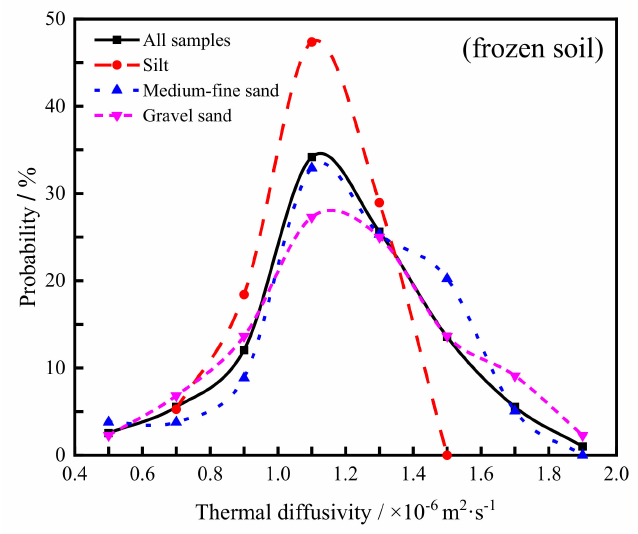
Figure 7. Probability distribution of thermal diffusivity of frozen soil with different particle